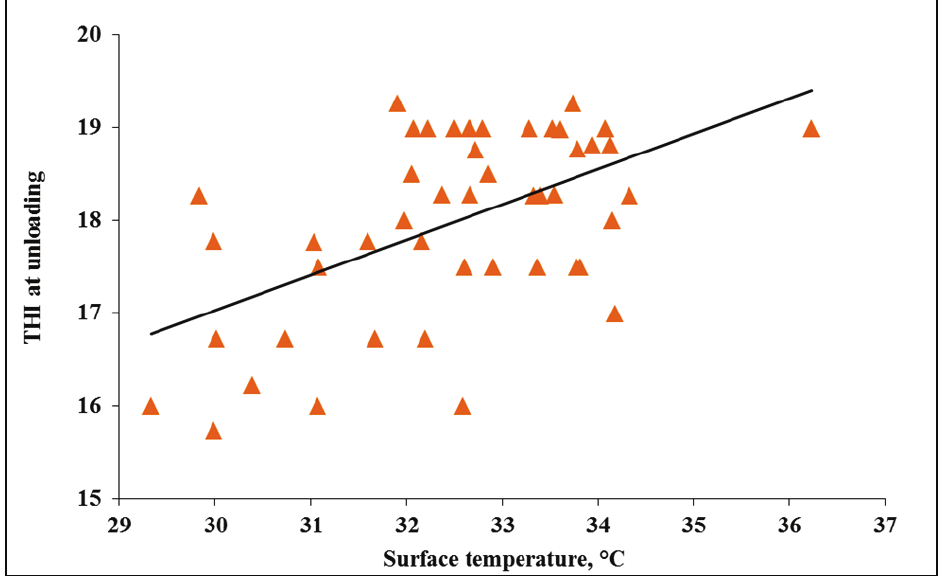
Figure 1. Experiment 1. Effects of temperature humidity index (THI) at unloading on surface temperature of market weight pigs at unloading in WARM weather (<26.7 °C; p < 0.01, R 2 = 0.41).